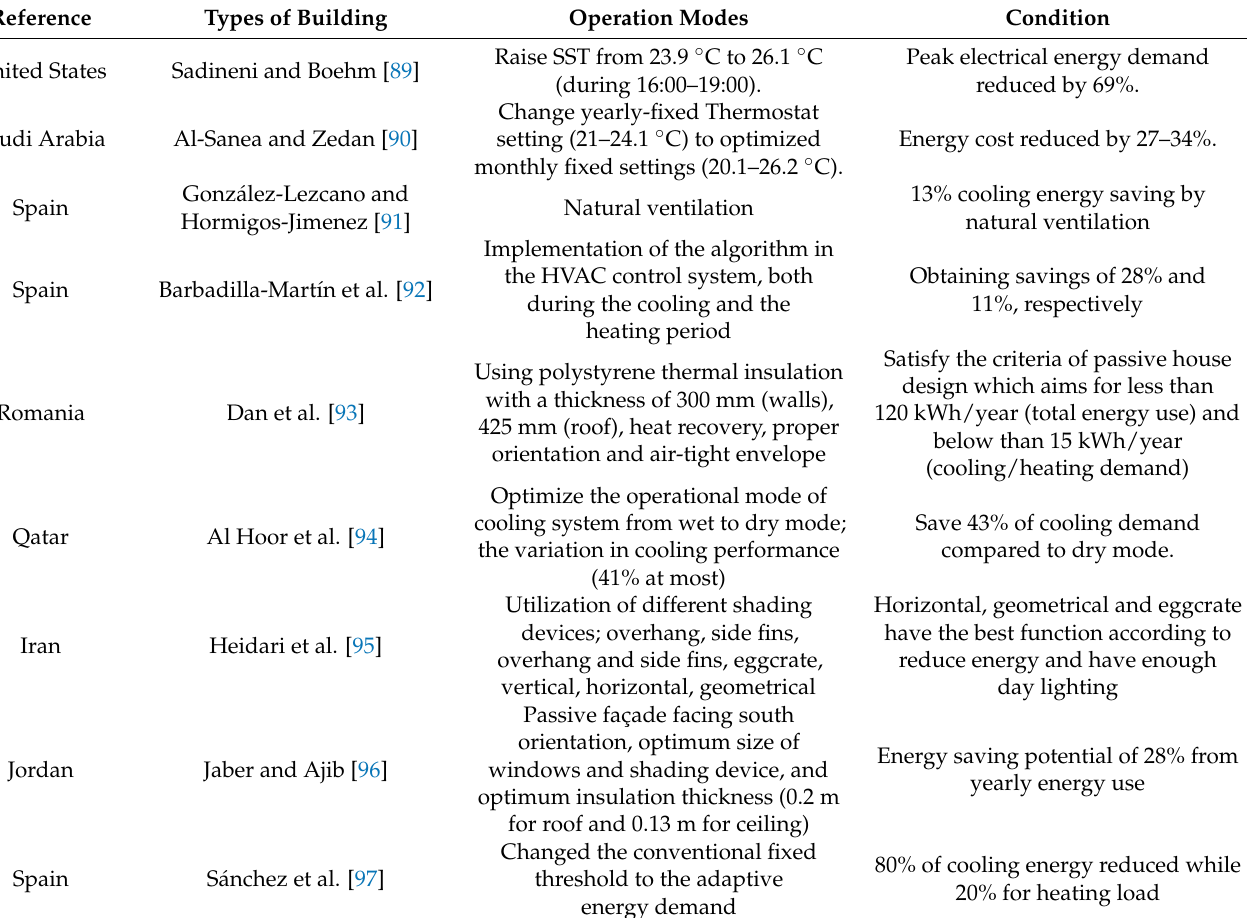
Table 5. Energy saving potential by adaptive measures from previous